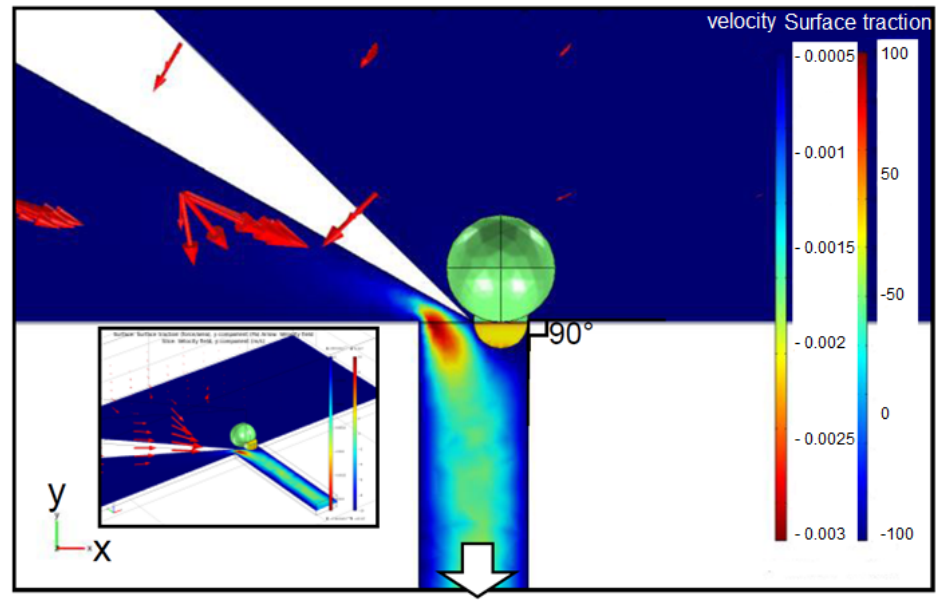
Figure 5. FEM results of the velocity distribution and the surface traction of oocytes in the Y-direction. Object surface: y component of surface traction (force/area) (Pa). Arrow: Velocity field, Slice: y component of velocity field (m/s).